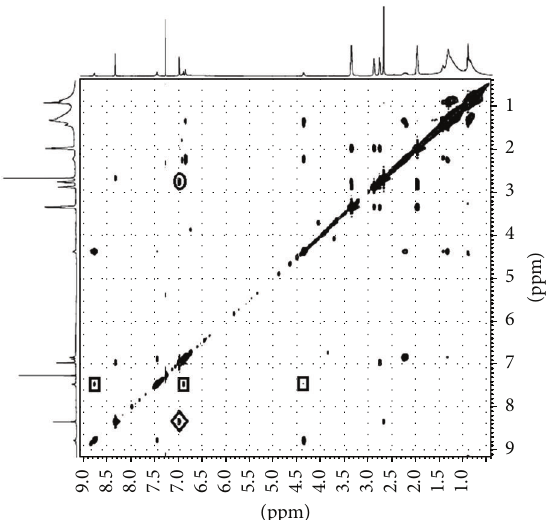
Figure 7: 2D ROESY NMR spectrum of the C334-C-HPA